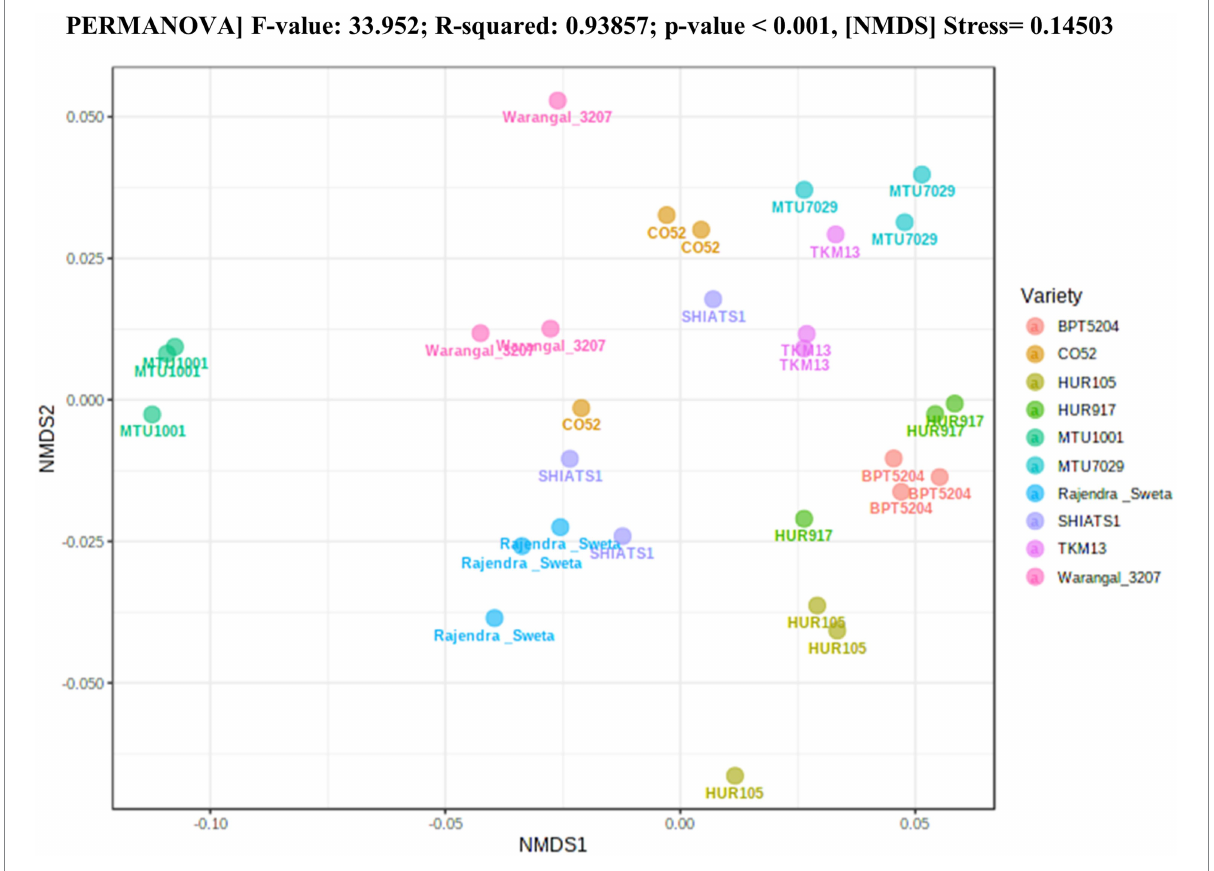
FIGURE 9 Principal coordinate analysis to reveal statistically significant differences in the association of various KEGG orthologues-based functions associated with rhizo-microbiome of rice varieties. To perform the clustering PERMANOVA based on NMDS was